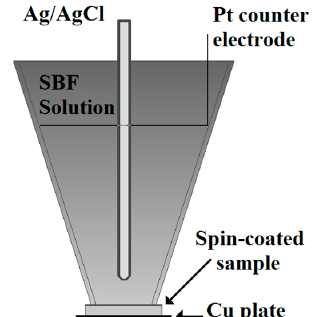
Figure A1. Experimental setup for electrochemical measurements. The distance between reference electrode (Ag/AgCl) tip and the surface of sample was constant for all the measurements.